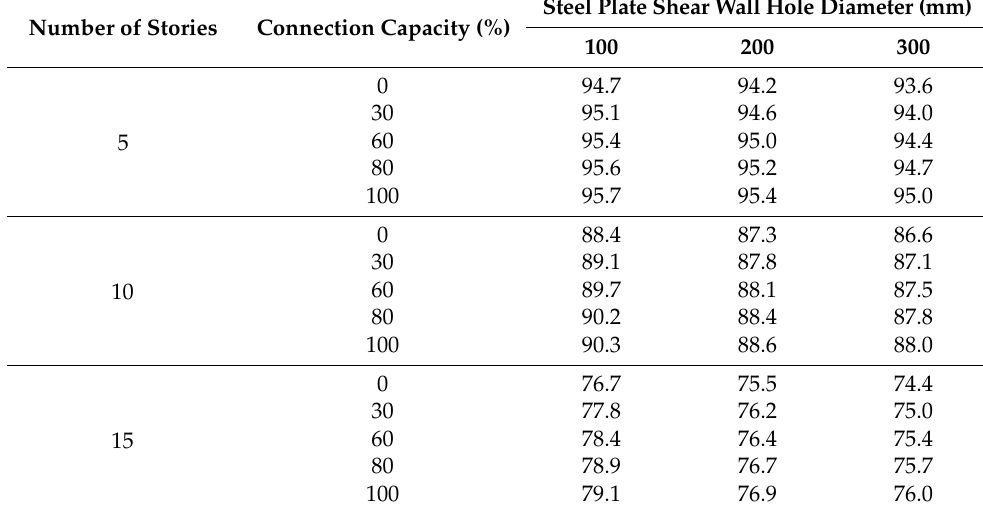
Table 6. Modal participation ratio of the first vibration mode